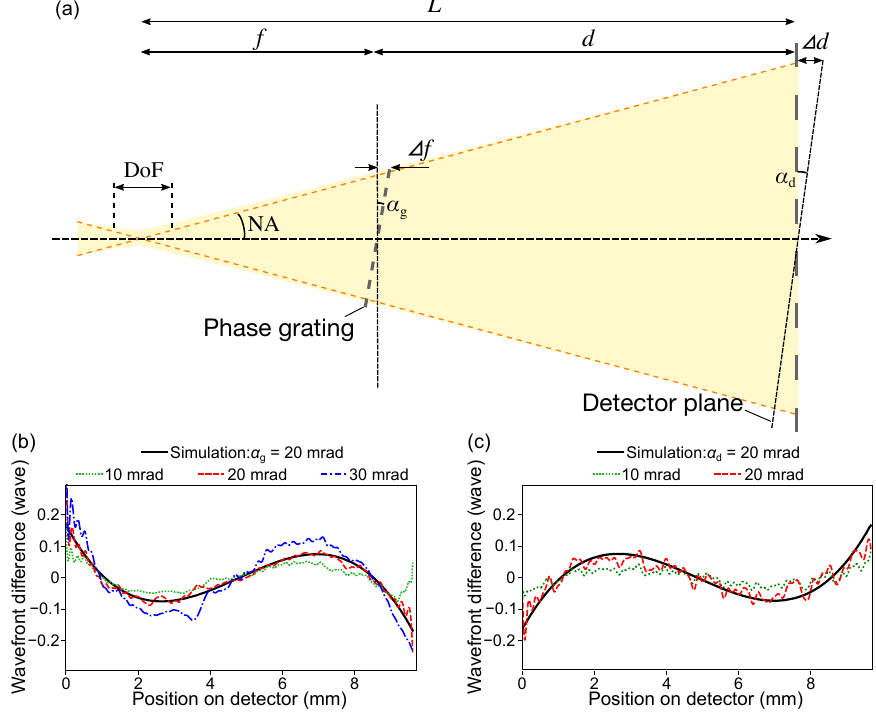
Figure 5. ( a ) Schematic illustration of the single-grating interferometer (s-GI) when the tilt errors of the grating and the detector are induced. ( b , c ) Results of the experiments and simulations for investigating the influence of tilt errors of the grating ( b ) and the detector ( c